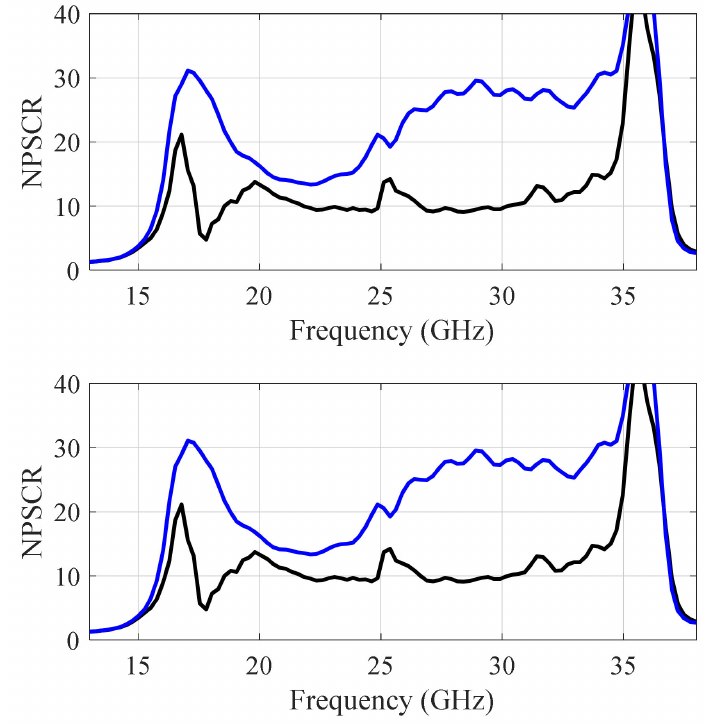
Figure 7. RCS performance evaluated using NPSCS of (4) when θ min = 30 ◦ ( top ) and when θ min = 45 ◦ ( bottom ). The black and blue color corresponds to checkerboard and optimized metasurface perfor- mance,